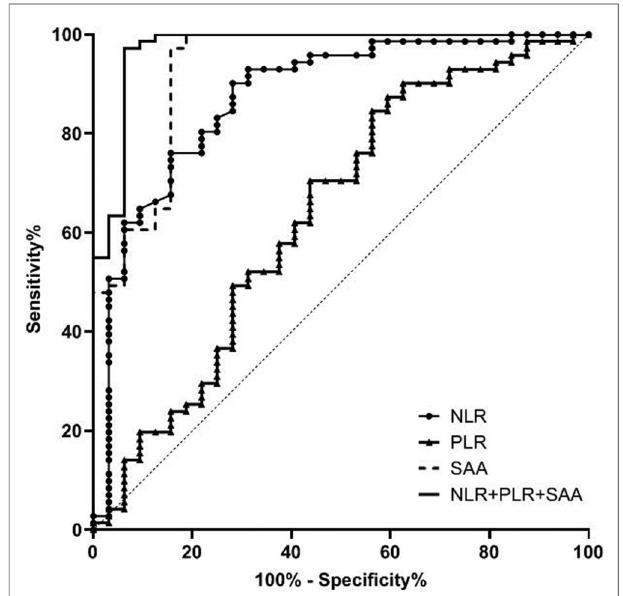
FIGURE 4 | Value of serum NLR, PLR and SAA levels in predicting patients with stage IV